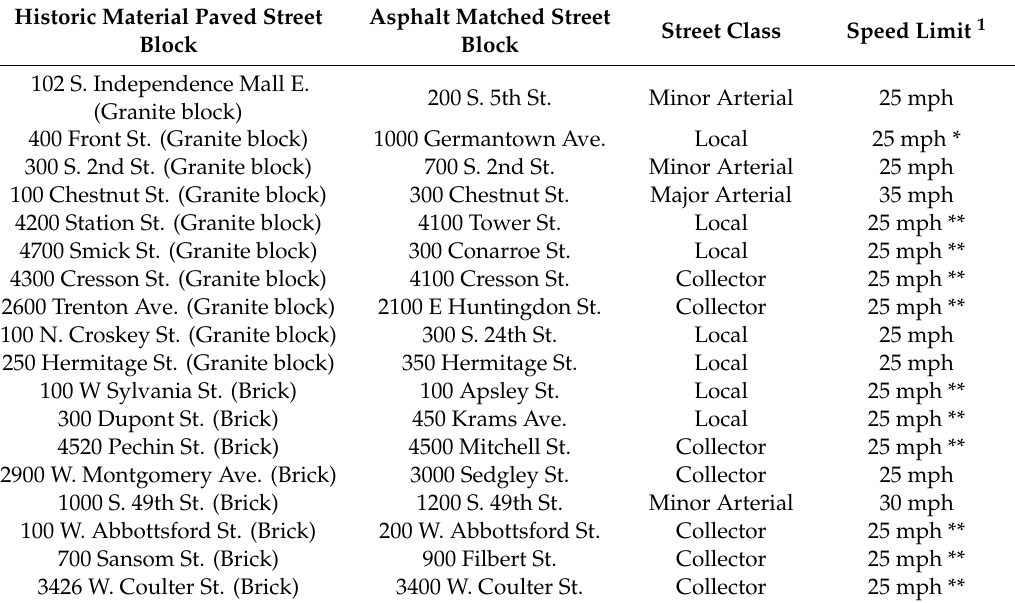
Table 1. List of historically paved street blocks and their asphalt paved